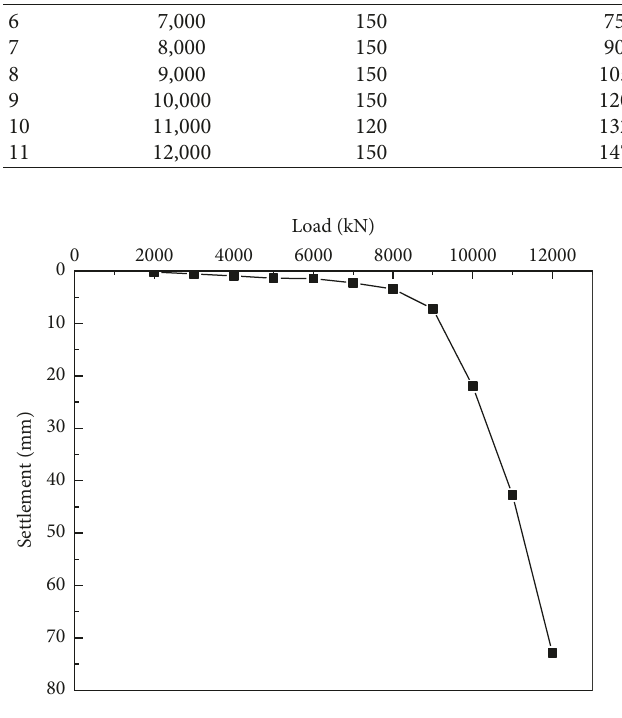
Figure 7: The Q-S curve of the test pile.